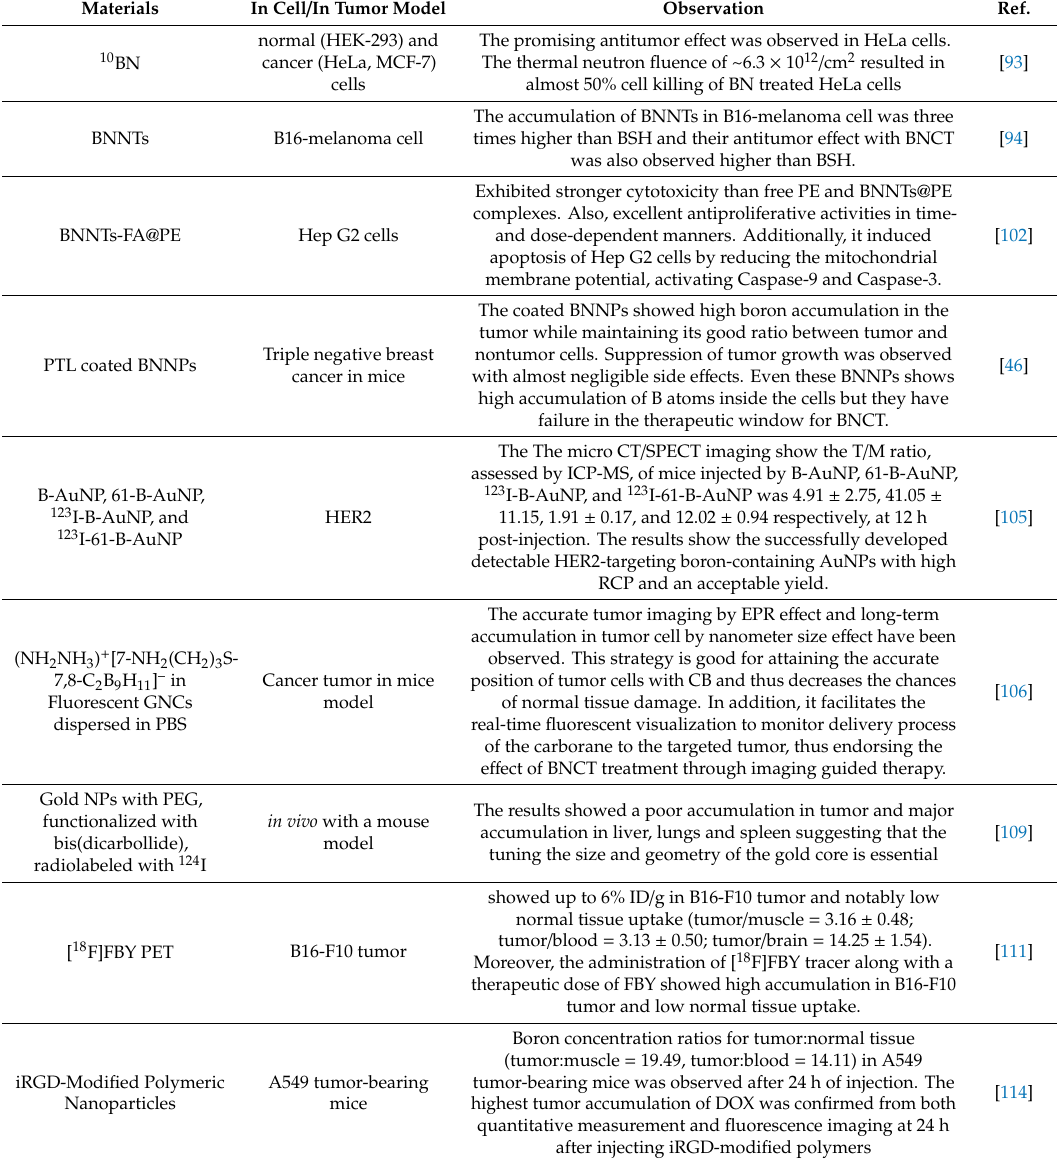
Table 1. Summary of recently reported boron-based delivery agents in